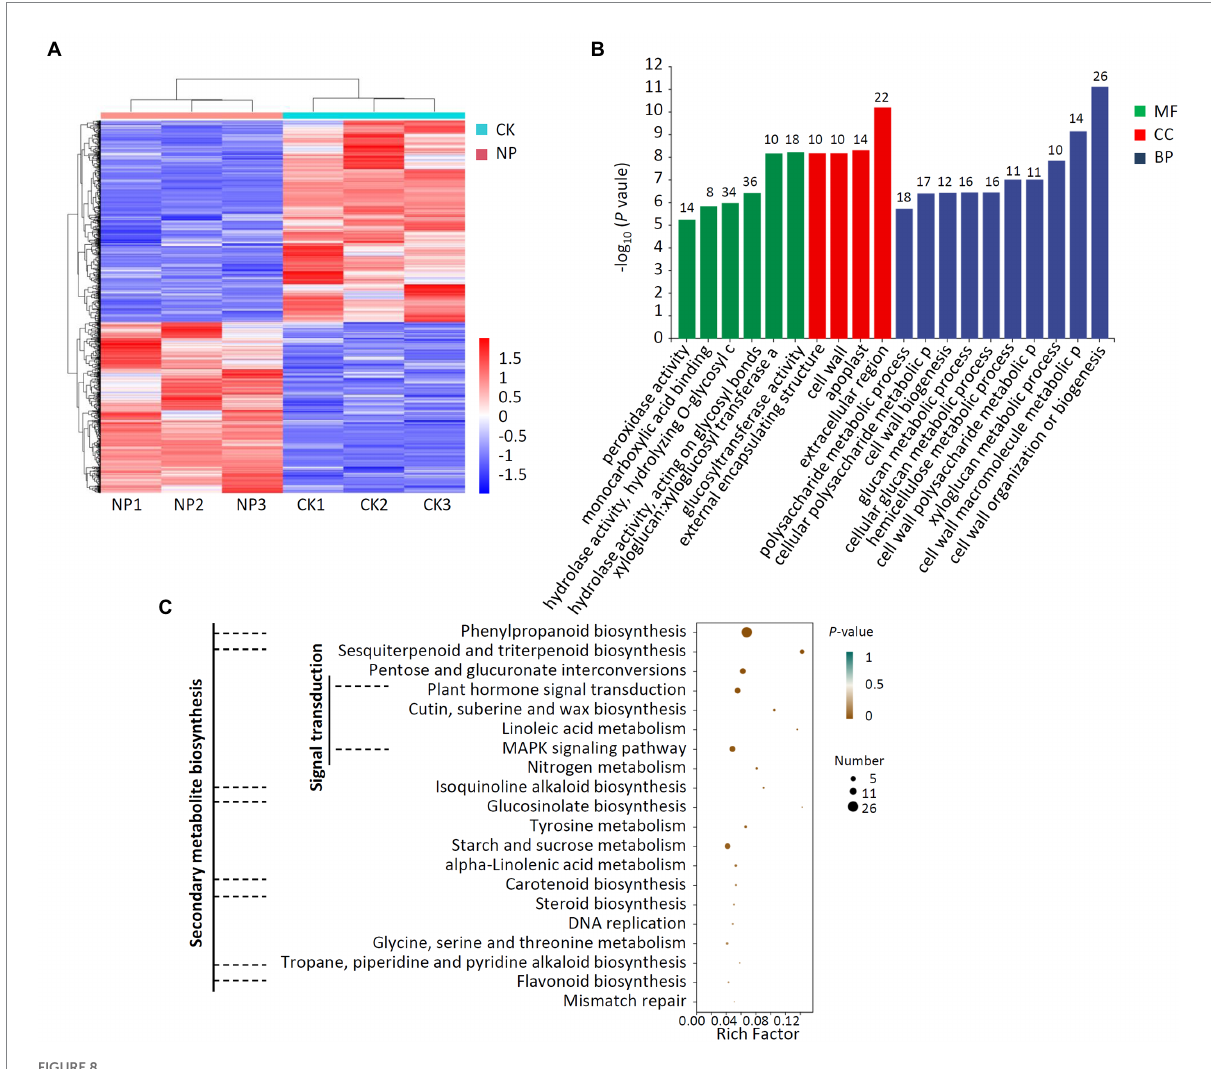
FIGURE 8 Transcriptome analysis of DEGs in pear twigs treated with P. polymyxa strain Nl4. (A) Heat map analysis. CK, untreated pear twigs; NP, strain Nl4 treated pear twigs. Red indicates highly expressed genes, and blue indicates low expressed genes. (B) GO annotation analyses of DEGs. The number above the column represents the number of DEGs. (C) KEGG pathway enrichment analyses of the DEGs. Rich factor = DEGs number/total gene number identified from transcriptome of a certain